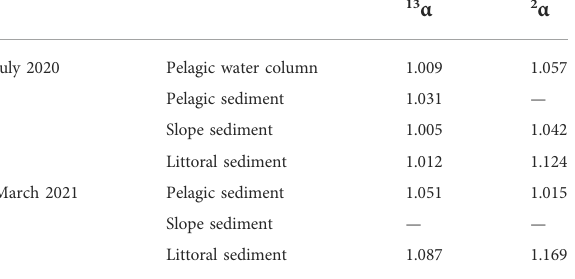
TABLE 1 Isotopic fractionation factors for carbon ( 13 α ) and hydrogen ( 2 α ) calculated for the for zones of decreasingCH 4 concentrations in the water column (bottom water to lower metalimnion) and in the uppersedimentduringthestrati fi cationperiod(July2020)andforthe upper sediment during the mixing period (March